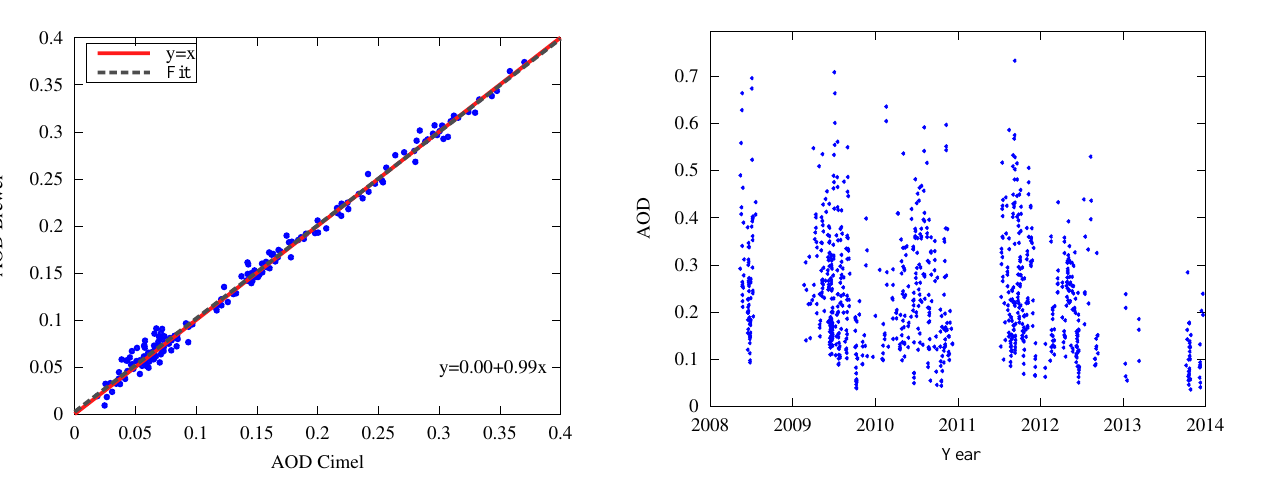
Figure 4. Scatterplot between AOD estimates by the Cimel and the Brewer during the intensive campaign.